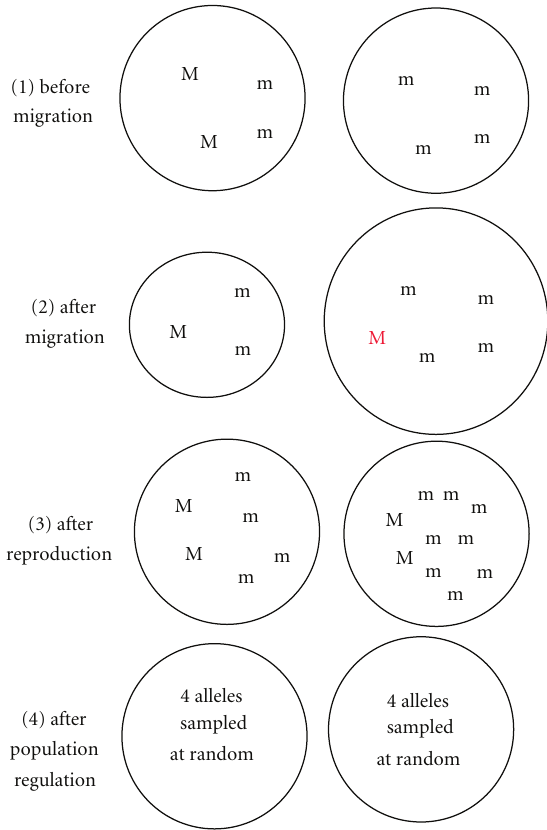
Figure 3: Kin selection on a migration modifier. Sketches how a migration modifier evolves because of kin selection. As in Figure 2, the M allele causes maximal migration (1/2) and the m allele specifies zero migration). Before migration (step 1), consider two subpopulations. In one of them the M allele is frequent (1/2), but it is absent in the other. During migration, only M individuals move between habitats (step (2), the migrant is shown in red). Half of the M individuals move to the other habitat and the other half stays at home. Then reproduction occurs (step 3). All individuals produce say, two o ff springs (note that all individuals have the same survival and reproduction). Finally, population regulation occurs: juveniles compete to repopulate each subpopulation with four adults and all have the same chance to get established. After this step, the M frequency has risen to (1/3 + 1/5)/2, which is greater than 1/4, the initial frequency. There is thus selection on M allele, which is traditionally explained in terms of “kin selection”: the migrating M allele sacrifices itself by competing in a more crowded population, but it leaves room behind that benefits the other M allele, which will compete in a less crowded population. The decreased chance of survival by the migrating M (1/5–1/4) is more than compensated by the increased chance that the remaining M allele will survive (1/3–1/4). This process requires only that the M alleles are concentrated in the same population at step 1 (i.e., it requires population structure or relatedness), which is easily generated by drift